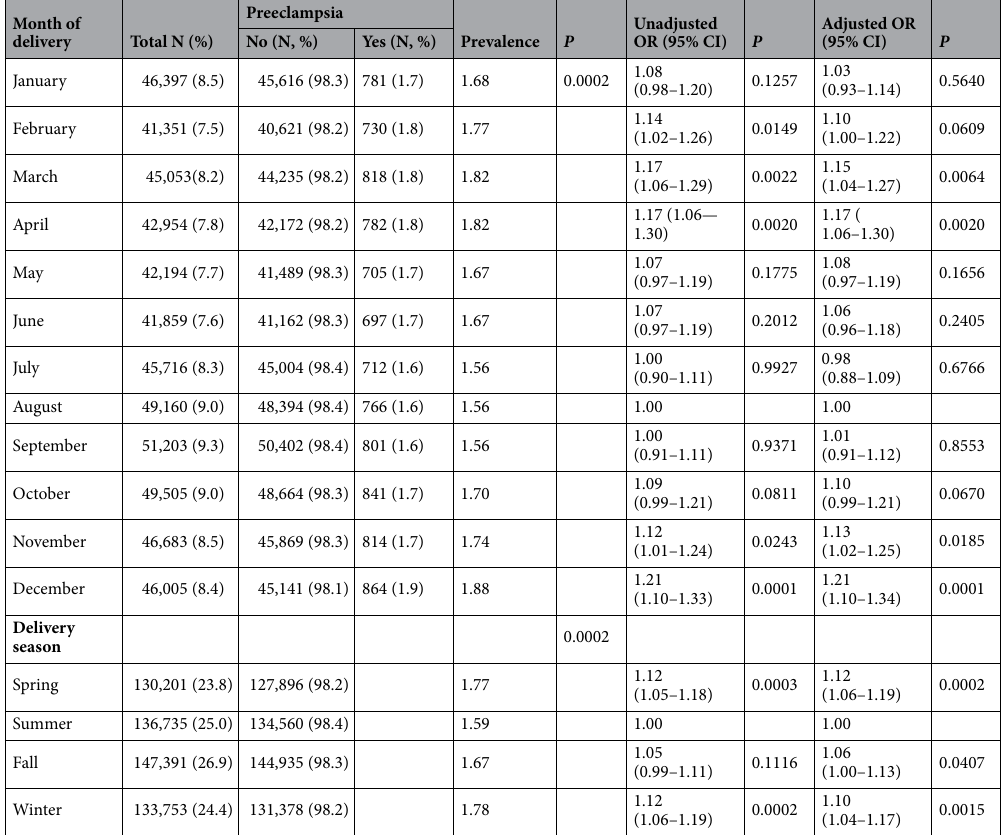
Table 2. Prevalence rates and ratios of preeclampsia according to the month of delivery, with August as the reference month. Adjusted for age at the time of delivery, income status, residential area, smoking status, drinking, physical activity, body mass index, history of hypertension before pregnancy, diabetes mellitus, and upper respiratory infection during pregnancy.